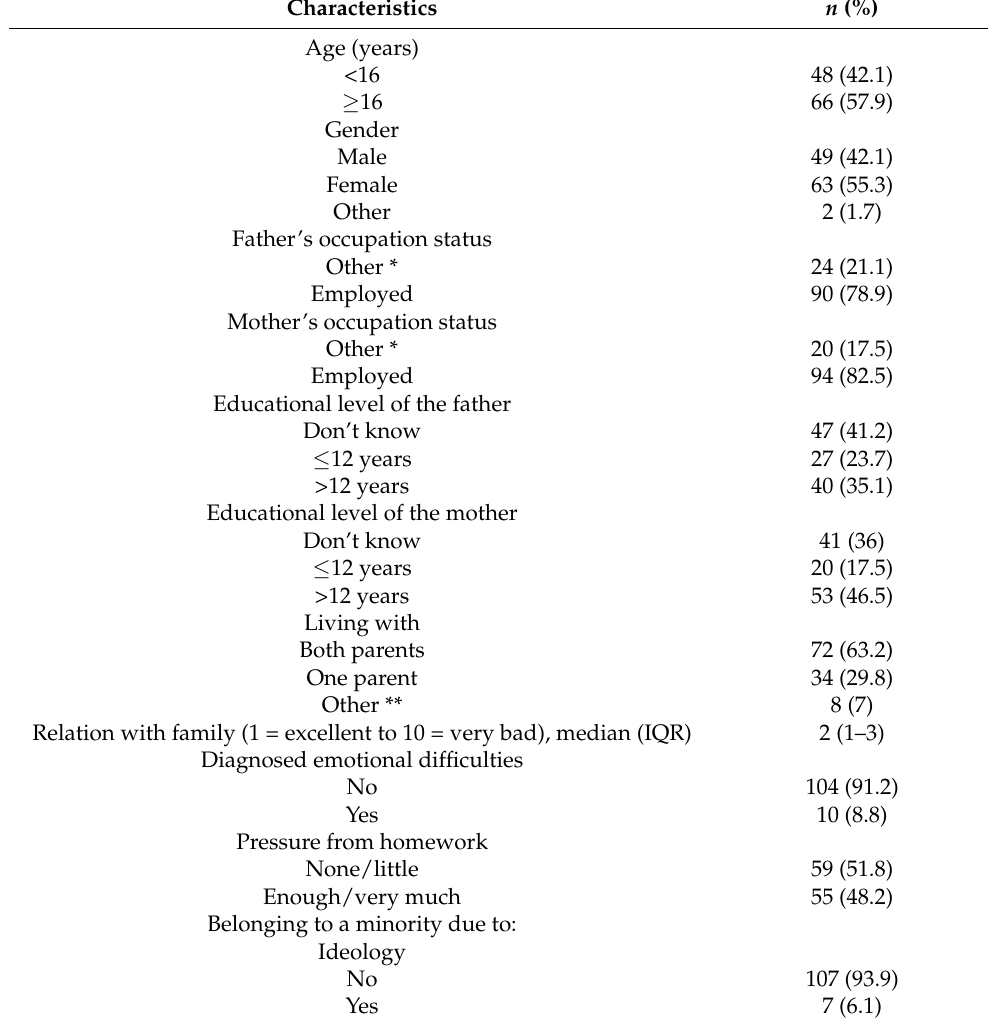
Table 1. Participants’ characteristics (N =